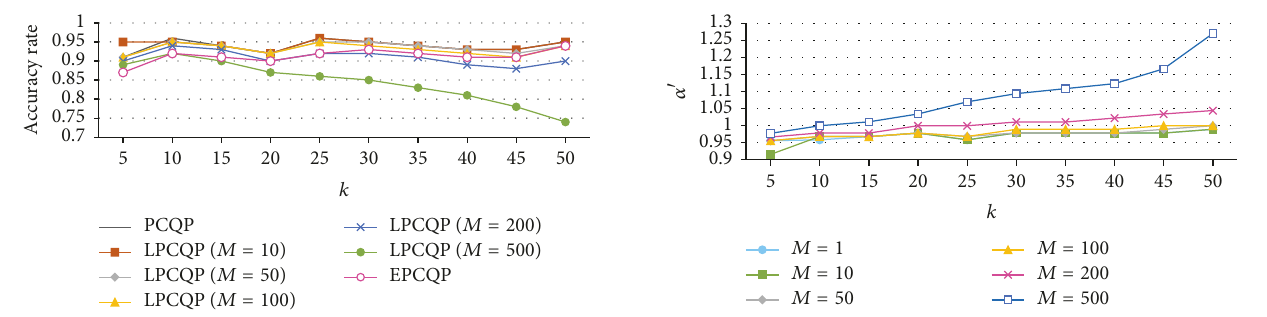
Figure 8: 𝛼 󸀠 versus k of the uniform dataset.